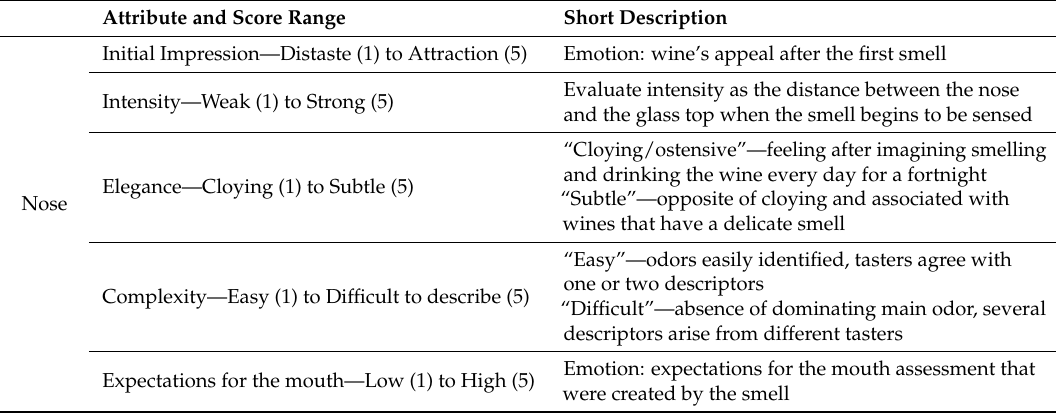
Table 2. Emotion-based tasting sheet and attribute